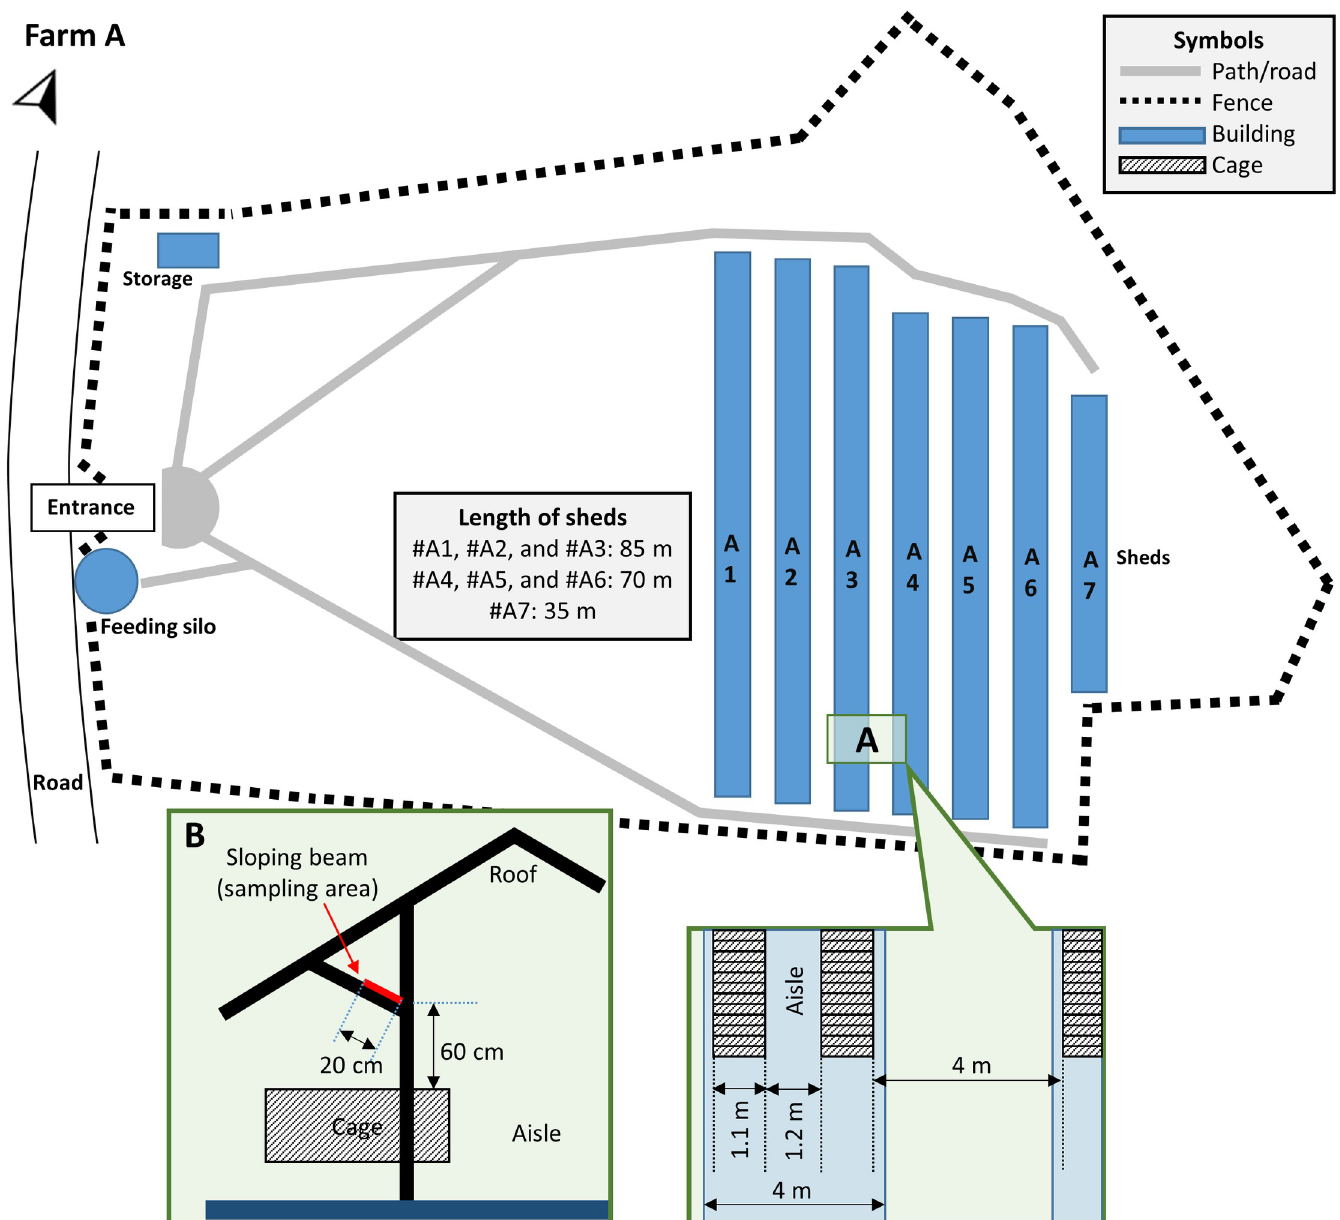
Fig 2. Floor plan of farm A. Inset A: floor plan detail, indicating the width of sheds, wire net cages, as well as the distances between them. Inset B: cross section of the sheds indicating the dust sampling area from the sloping beams (red marking).